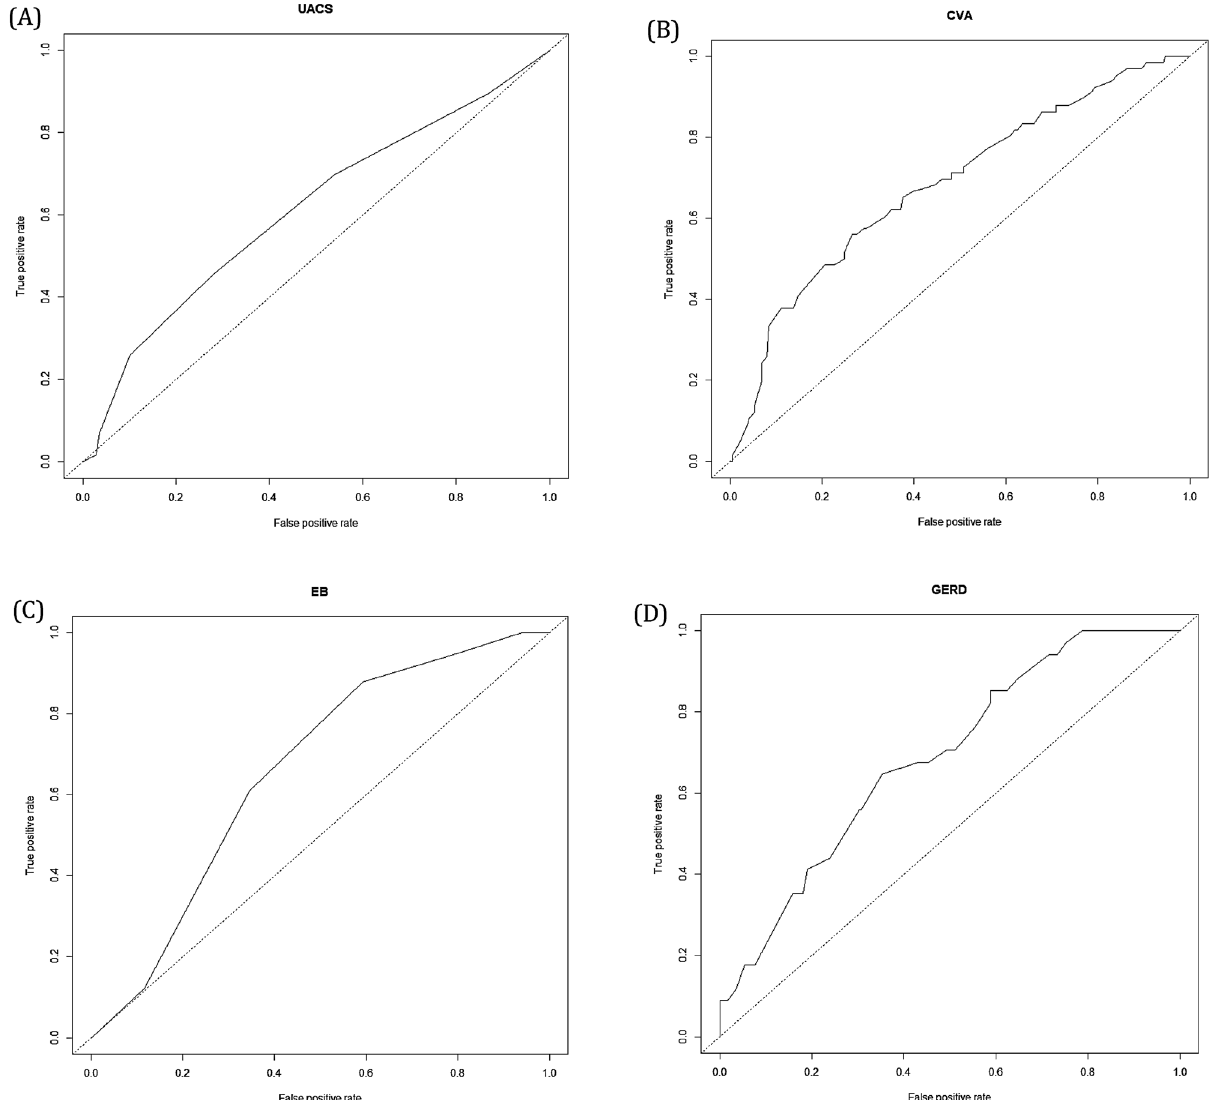
Figure 1. Receiver operating curve logistic regression for diagnosing upper airway cough syndrome ( A ), asthma/cough variant asthma ( B ), eosinophilic bronchitis ( C ), and gastro-esophageal reflux disease ( D ). Area under curve of the receiver operating characteristics curve (AUC) of UACS, CVA, EB, and GERD: 0.60, 0.71, 0.70, 0.77,